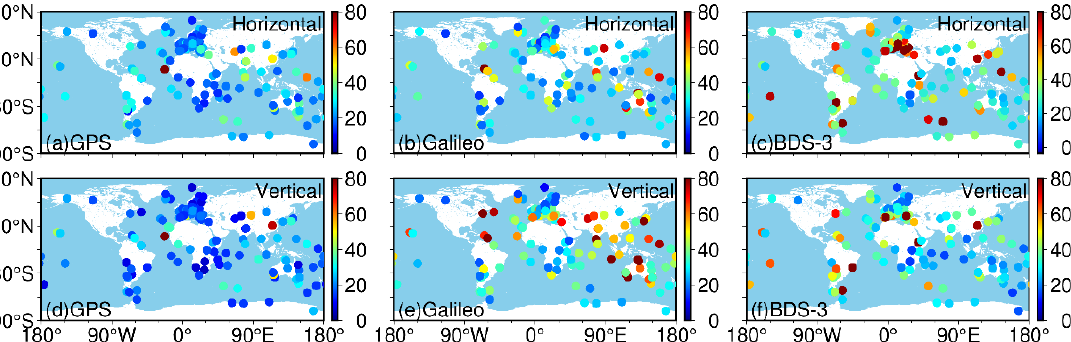
Figure 8. Geographical distribution of the median convergence times of kinematic PPP for the selected 143 worldwide MGEX tracking stations over a month (September 2022) using three single systems. Table 3. The mean convergence times (unit: min) of the different latitudes for kinematic PPP.